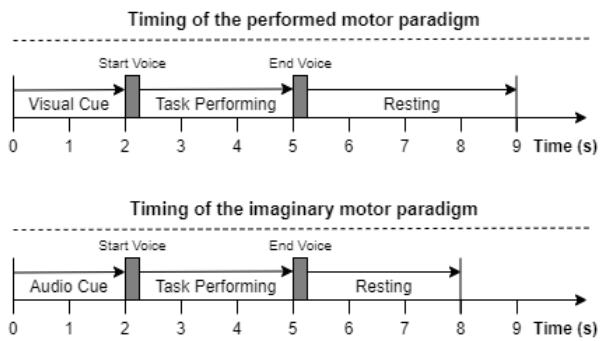
Figure 1. Timing of the tasks, showing resting period and instruction, start, and end cues (see text).